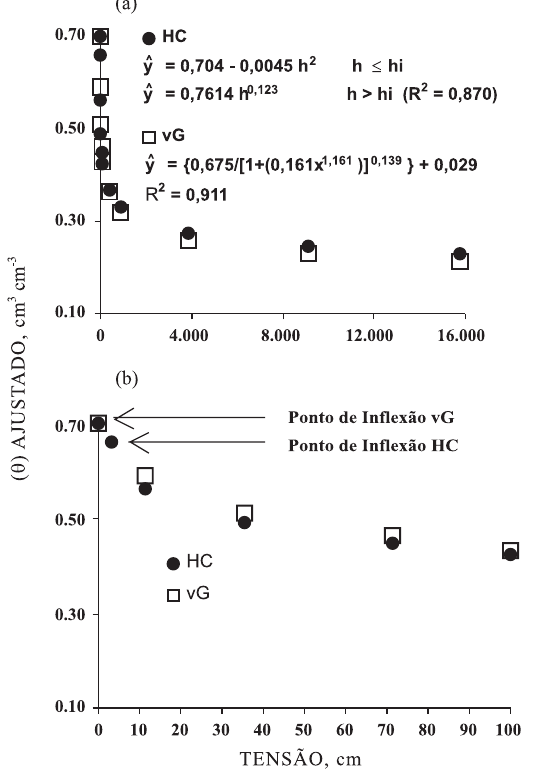
Figura 1. Dados ajustados de teor de água ( θθθθθ ) e respectivas curvas de retenção de água no solo, obtidos com amostras deformadas, pelo método da centrífuga, considerando as equações propostas por van Genuchten - vG e Hutson